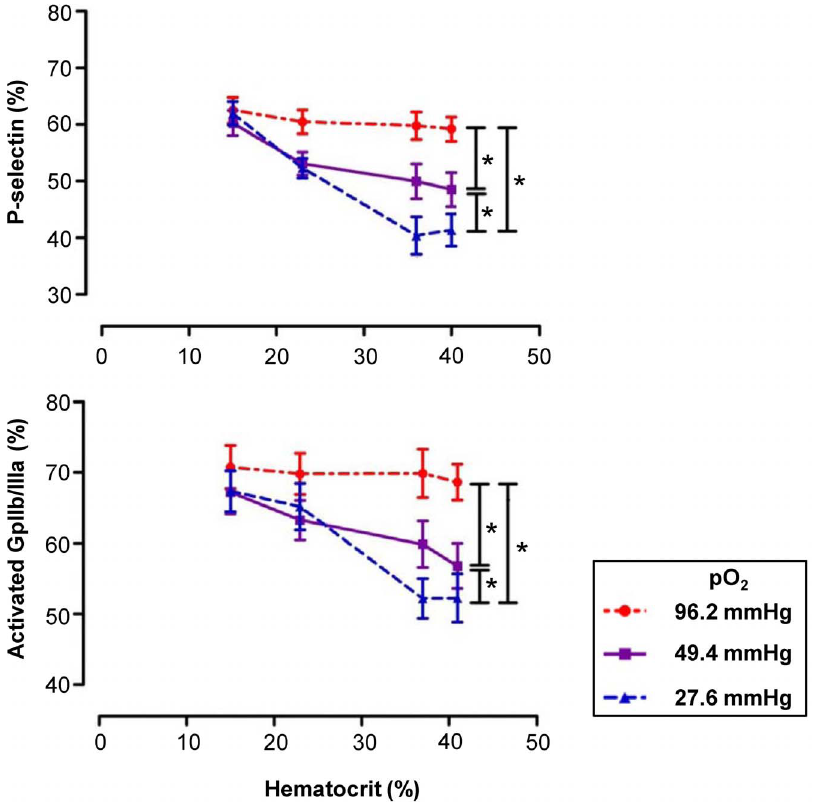
Figure 4. Effect of hematocrit changes on the thrombin-induced platelet activation in platelet-rich plasma + erythrocytes. Nitrite (1 m M) was added to platelet-rich plasma + erythrocytes with various hematocrits (15.4 6 1.8, 23.0 6 2.3, 36.7 6 1.6, 40.2 6 1.2%) before thrombin (1 U/